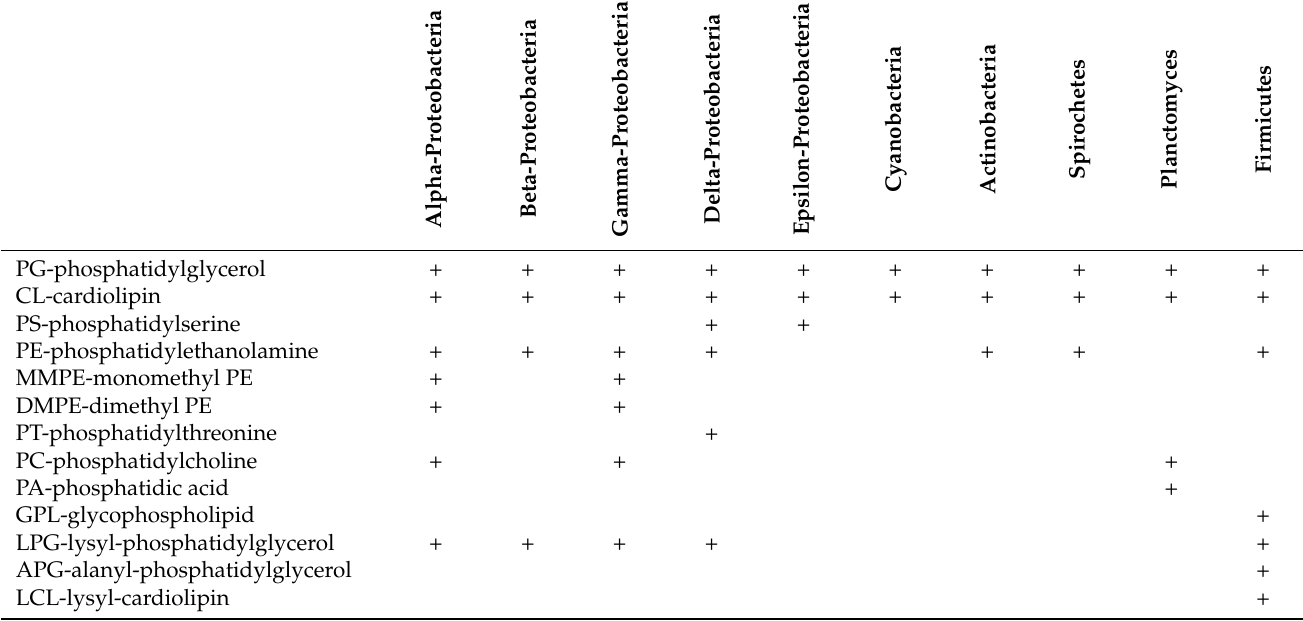
Table 1. Main phospholipids constituents of bacterial membranes (according to [65]; ‘+’ indicates that given phospholipid was identified in several representants of mentioned bacteria